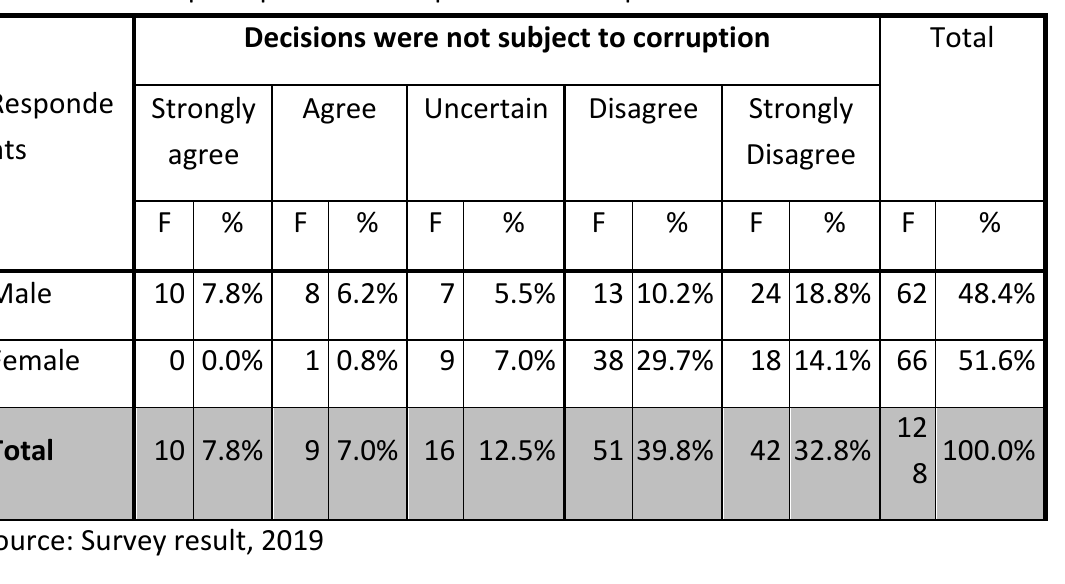
Table 15: Public perception of corruption in municipal court